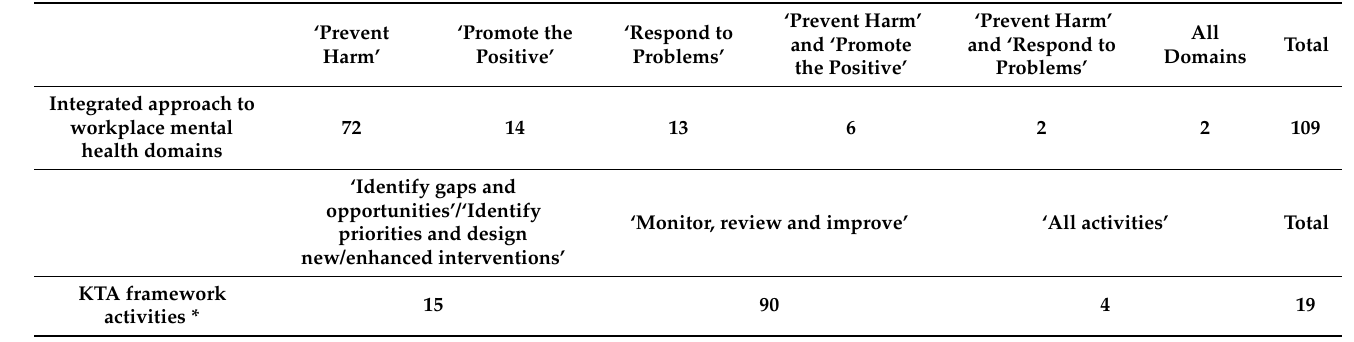
Table 4. Mapping of instruments to integrated approach domains and knowledge to action (KTA)